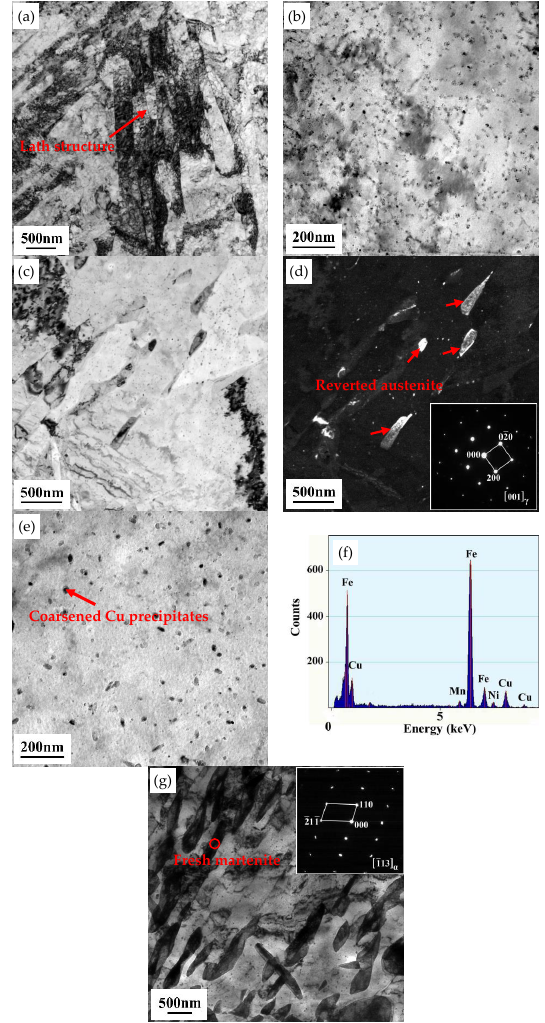
Figure 5. Transmission electron microscopy (TEM) micrographs of the tested steel: ( a ) partially recovered lath structure after aging at 600 ◦ C, ( b ) uniformly distributed precipitates in the matrix after aging at 600 ◦ C, ( c ) bright-field (BF) image after aging at 650 ◦ C, ( d ) dark-field (DF) image of reverted austenite and its selected area electron di ff raction (SAED) pattern (inset) after aging at 650 ◦ C, ( e ) coarsened precipitates after aging at 650 ◦ C, ( f ) composition determined by energy dispersive X-ray spectrometer (EDS) for the arrowed particle in ( e ), ( g ) BF image showing reverted austenite partially transformed to martenite after aging at 700 ◦ C and its SAED pattern (inset) taken from the region indicated by a red